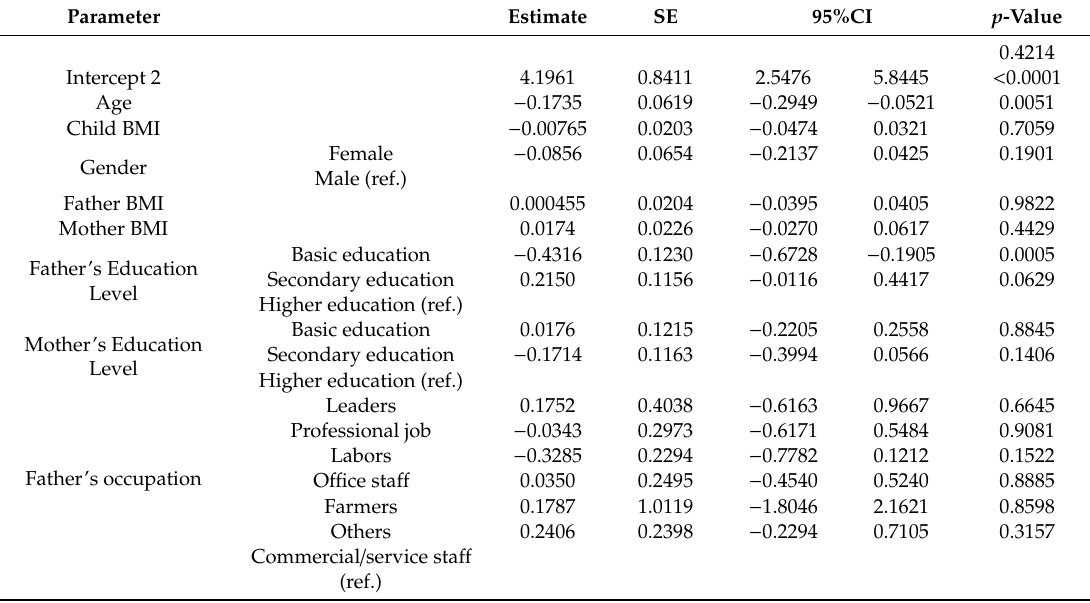
Table 6. Ordered multivariate logistic regression for children’s eating